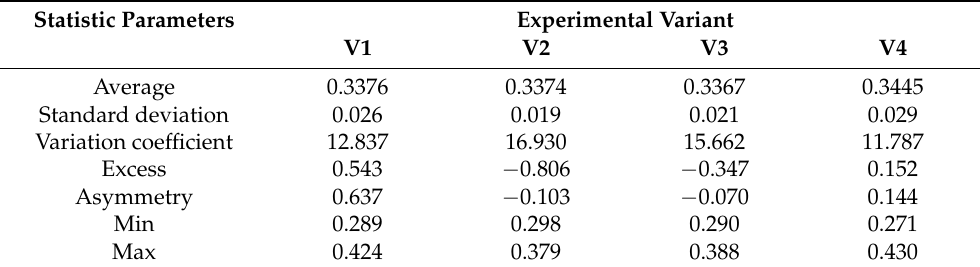
Table 1. General statistical parameters (average, standard deviation, variation coefficient—%, asym- metry, excess, minimum and maximum) for density (g · cm − 3